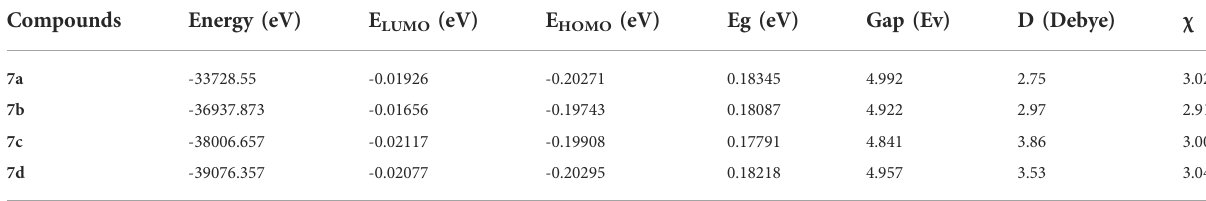
TABLE 6 Energies, band gap, dipole moment (Debye), and electronegativity.